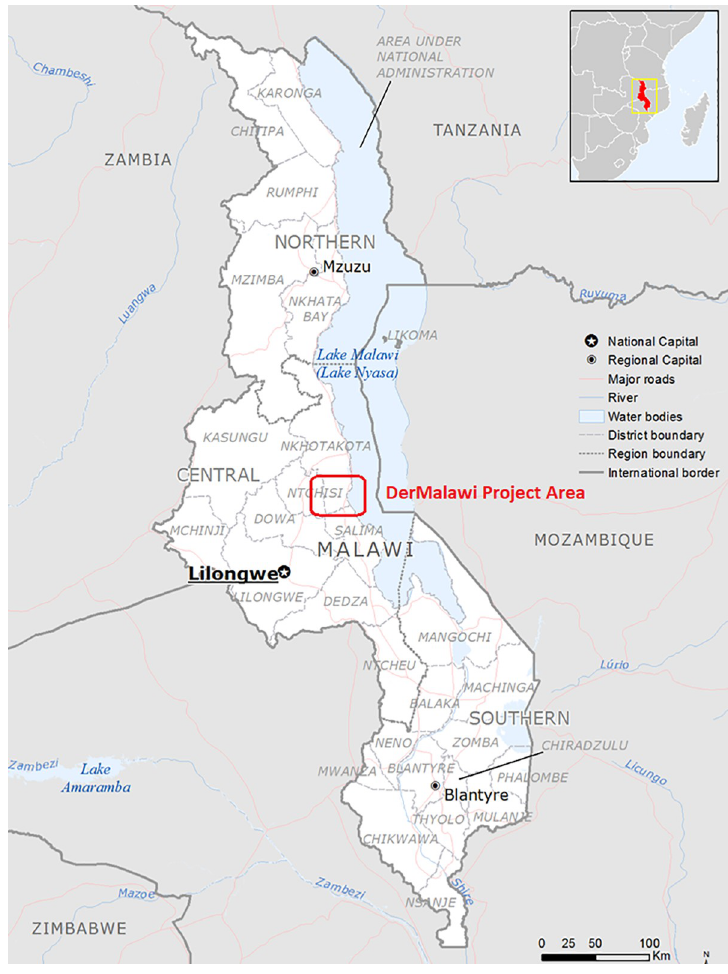
Fig 1. Map of Malawi indicating the location of the DerMalawi Project (Base layer: https://commons.wikimedia.